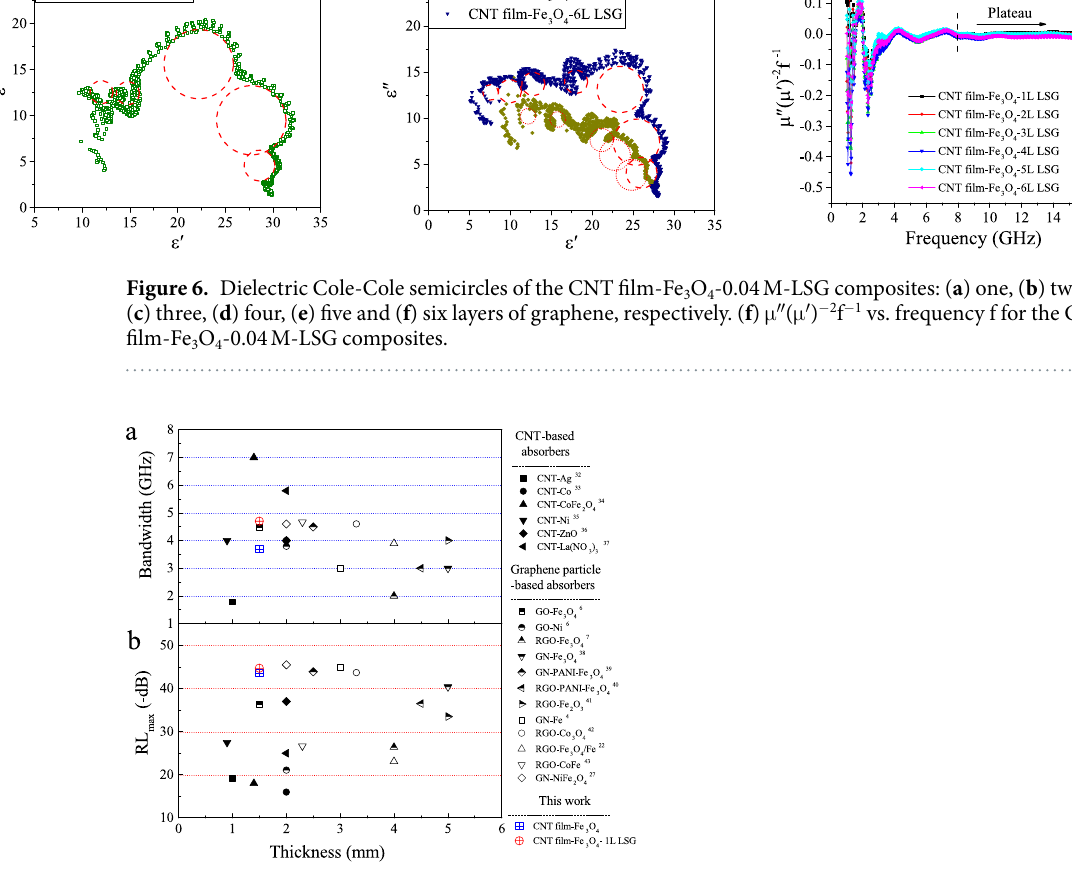
Figure 7. Maximum of reflection loss, absorbing bandwidth and thickness of this work compared with those of previously reported graphene- and CNT-based wave-absorbing composites: ( a ) absorbing bandwidth at − 10 dB, ( b ) maximum of reflection loss. (GN: graphene; GO: graphene oxide; RGO: reduced graphene oxide 4, 6, 7, 22, 27, 35–46